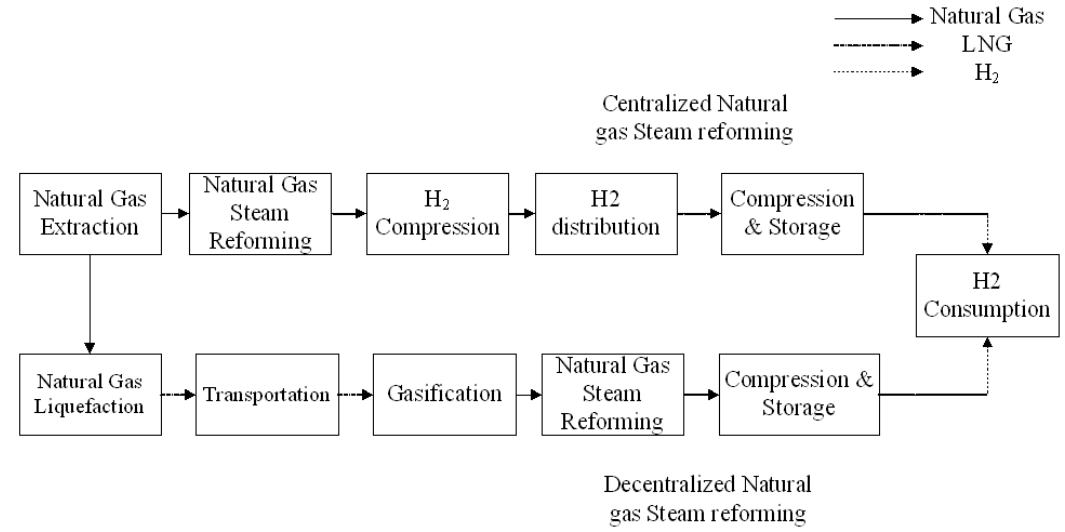
Figure 4. Hydrogen production process via natural gas steam reforming, centralized and decentralized forms.